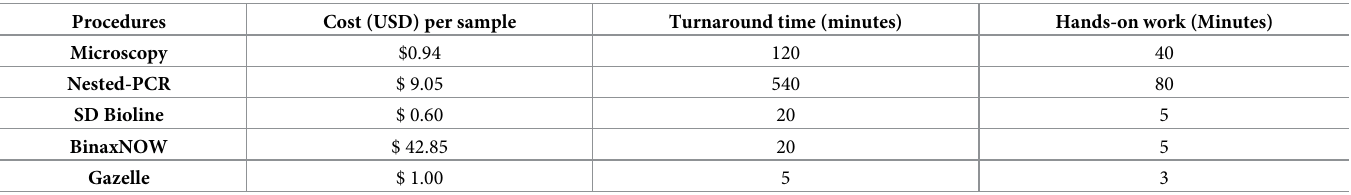
Table 2. Turnaround time and cost analysis. Estimated cost covers reagents and supplies for DNA extraction and slide preparation. No equipment no labor costs are